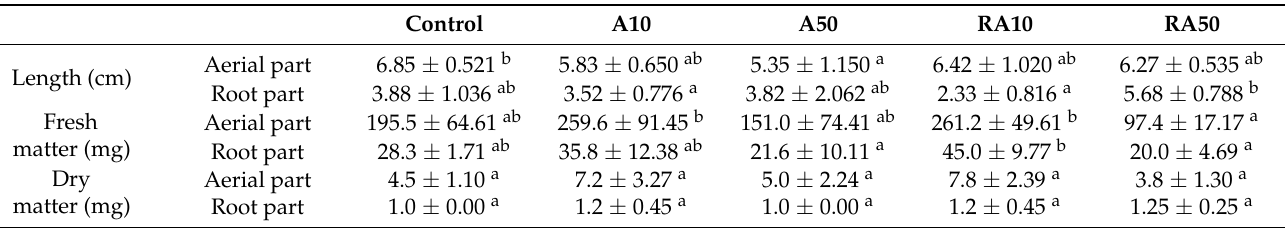
Table 2. Effects of A and RA treatments on length and biomass of shoots and roots. Different letters mean significantly different values ( p <